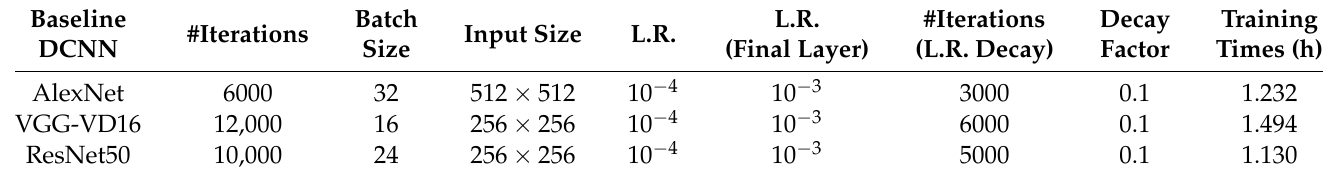
Table 7. Parameters utilized for the models with different baseline DCNNs on the AID data set.